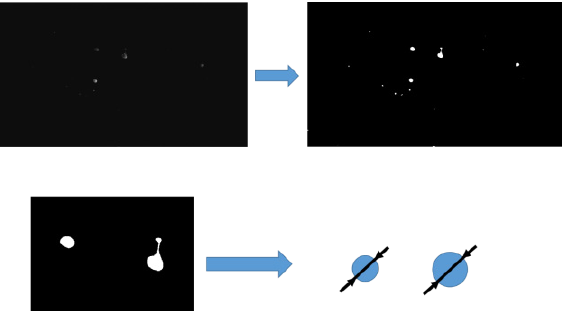
Fig.6. Process of droplets diameters evaluating